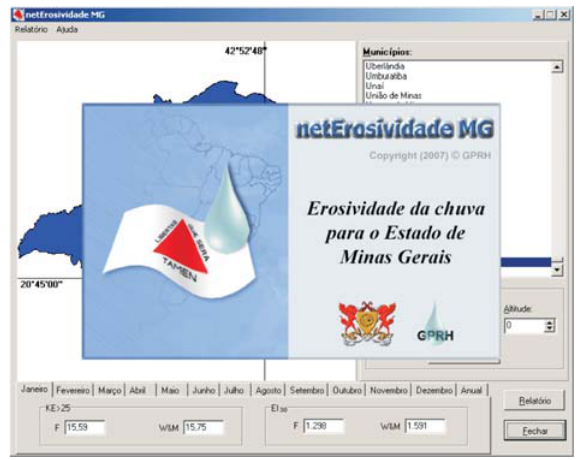
Figura 4. Relatório gerado pelo NetErosividade MG para a localidade de